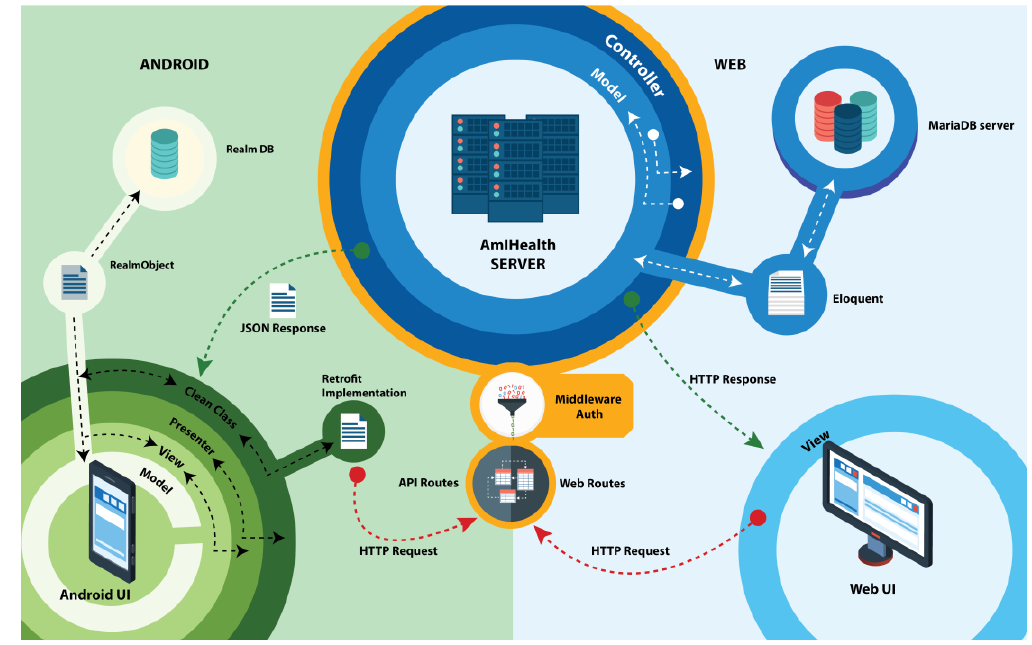
Figure 1. Overview of the platform architecture.